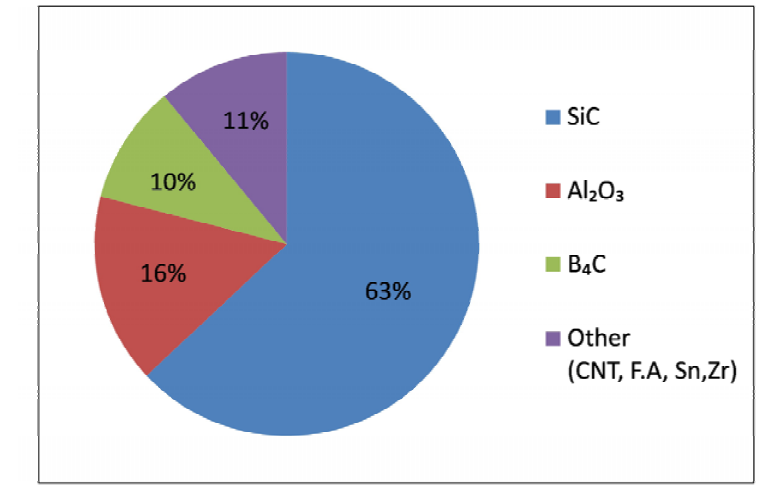
Fig. 2. Contribution (%) of different primary reinforcements used for fabricating graphite reinforced Al and Mg based MMHCs reviewed in this report.